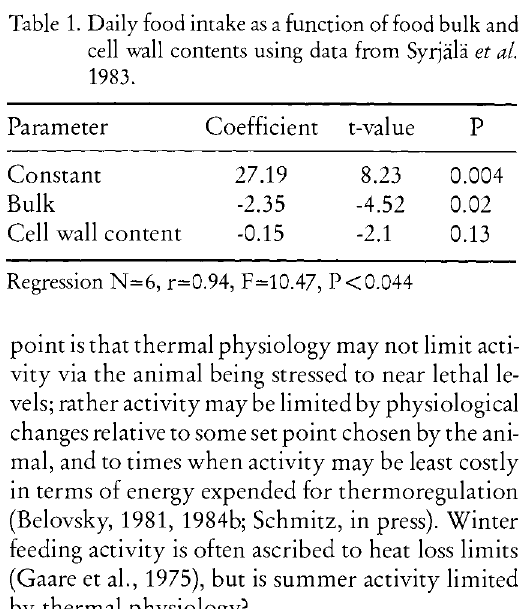
Table 1. Daily food intake as a function of food bulk and cell wall contents using data from Syrjala et al.